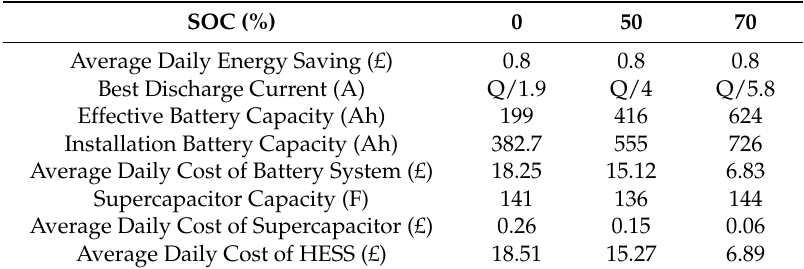
Table 4. Optimized results of daily cost of HESS at different